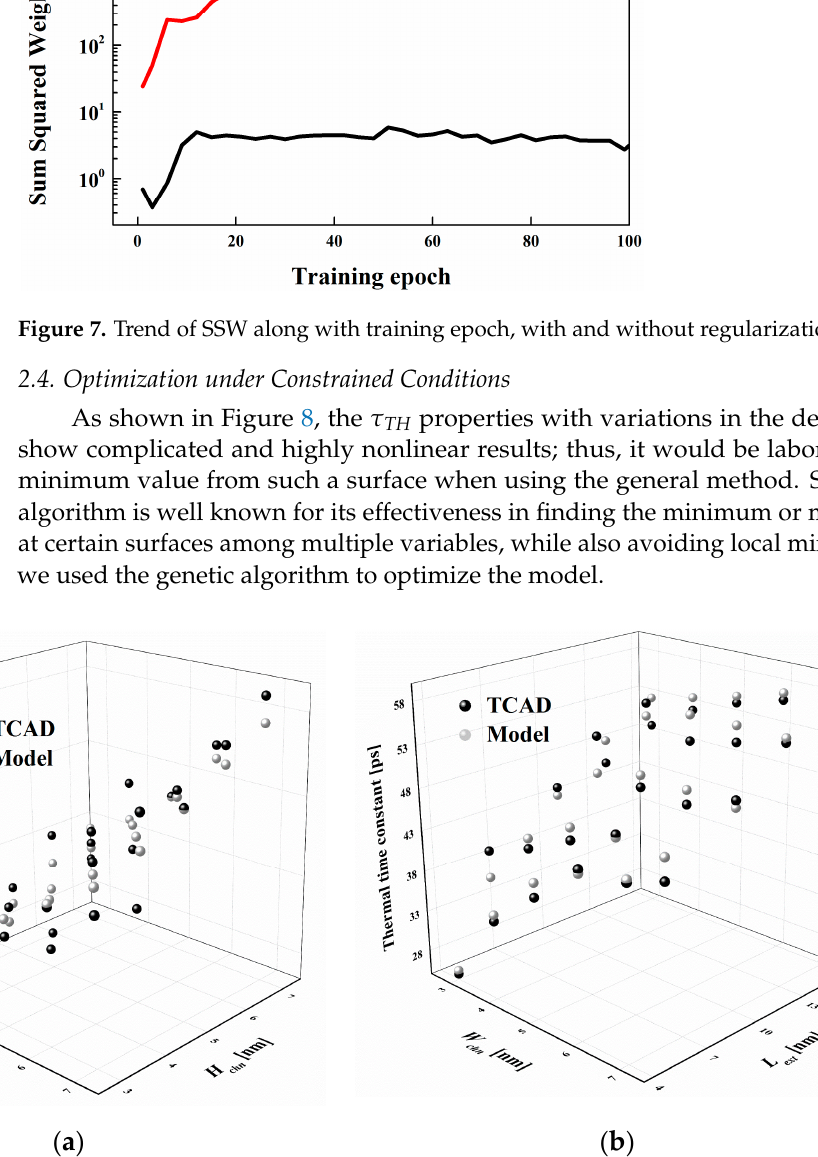
Figure 8. Scatter plot of thermal time constant, along with variation of ( a ) W chn and H chn , ( b ) W chn and L ext.